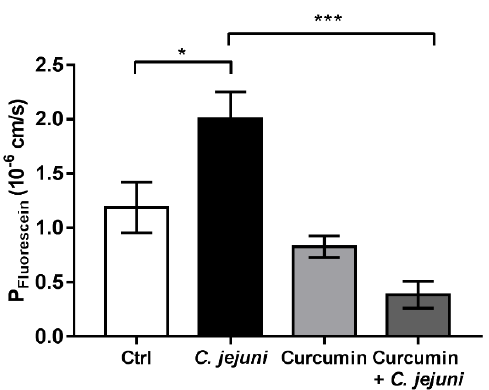
Figure 3. Curcumin improves the C. jejuni -induced increase in permeability to fluorescein (332 Da) in co-cultures with colon epithelial HT-29/B6-GR/MR and immune THP-1 cells. The co-cultures were infected with C. jejuni after incubation with 50 µM curcumin. Fluorescein permeabilities were measured 48 h post infection ( n = 7–8, * p < 0.05, *** p < 0.001, one-way ANOVA with Bonferroni correction for multiple comparisons).